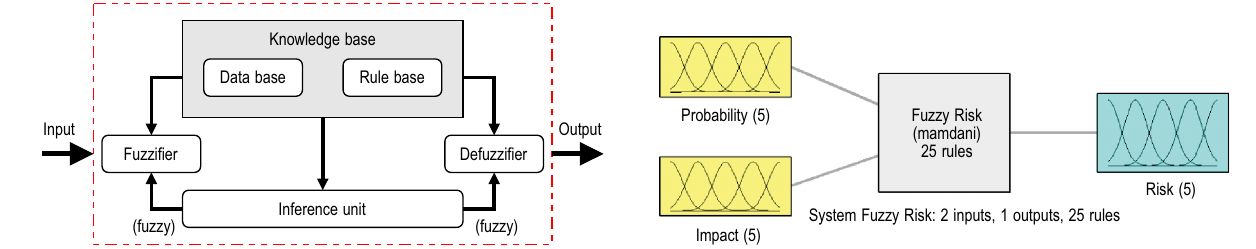
Fig. 7. Structure of the fuzzy model